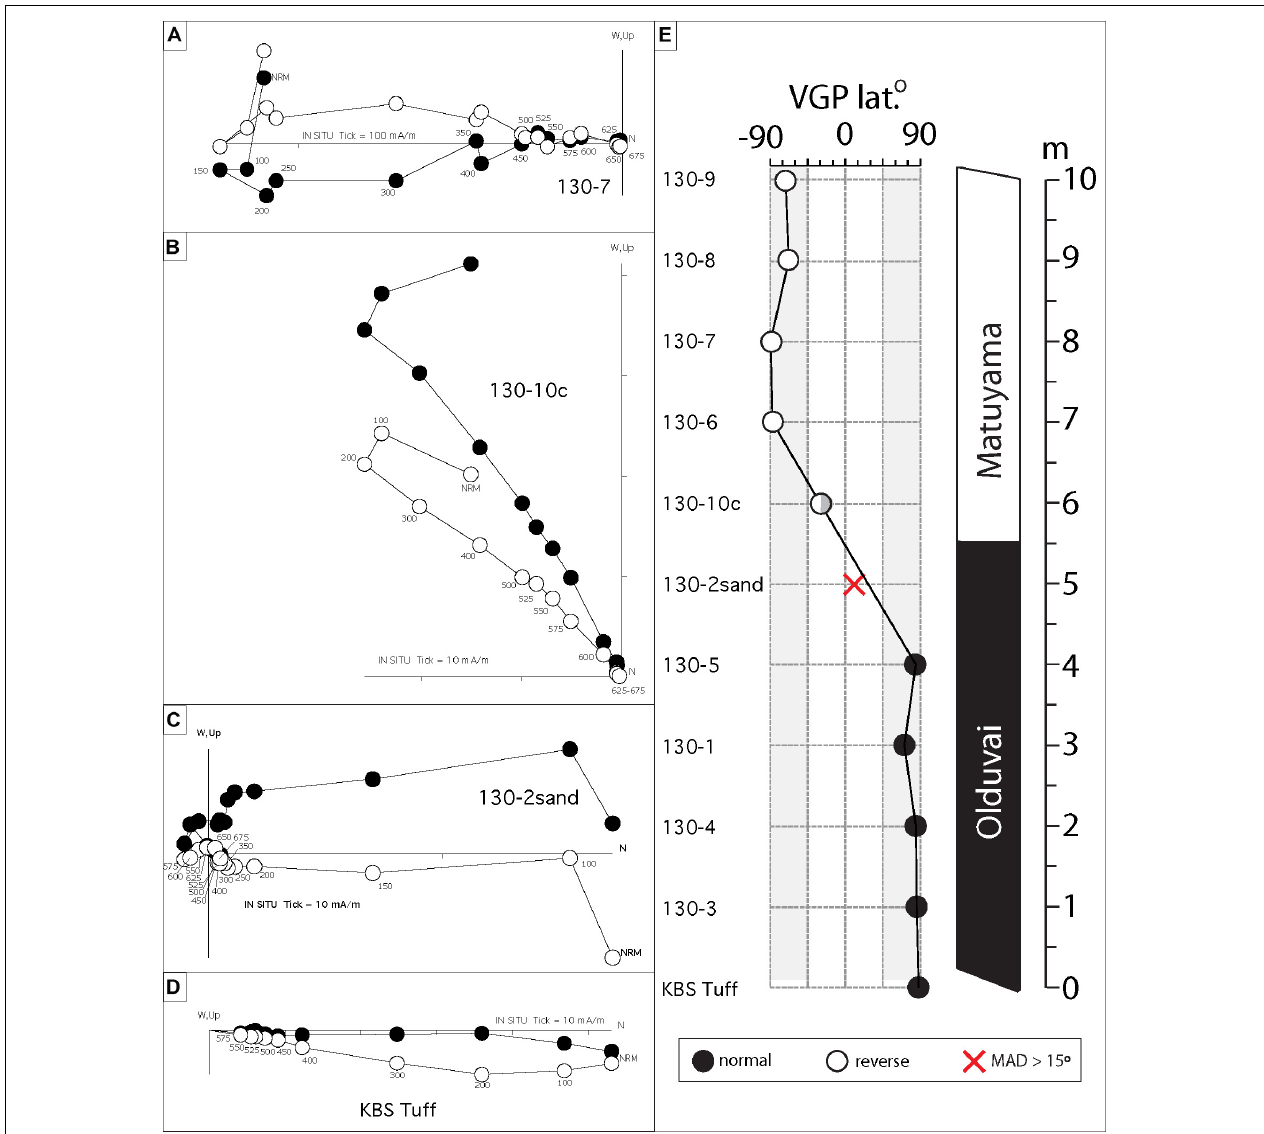
FIGURE 4 | Vector end-point plots of NRM thermal demagnetization data for representative specimens [ (A) 130-7, (B) 130-10c, (C) 130-2 sand, and (D) KBS Tuff] from the Area 130 section (see Figure 3 for stratigraphic positions). Open and closed symbols represent the vertical and horizontal projections, respectively, in bedding coordinates. Numbers next to symbols are thermal demagnetization steps in ◦ C. Coherent magnetizations are sometimes present above 575 ◦ C and suggest the presence of hematite in these samples. For sample 130-2sand the demagnetization trajectory clearly bypasses the origin and turns around to a reverse direction indicating a relatively strong normal polarity overprint. The Olduvai-Matuyama transition may be close to that sample level. (E) Results indicate the presence of a lower magnetozone of normal polarity from the KBS Tuff upwardly through the stratigraphic level of sample 130-5. An overlying magnetozone of reverse polarity is interpreted from samples 130-6 to 130-9 (filled black circles are normal polarity, open circles are reverse polarity, open circle with gray shading indicates probable reverse polarity with a declination direction within 90 ◦ of southerly, while the red cross symbol represents a sample with a MAD value > 15 ◦ and large normal polarity overprint, but has a thermal demagnetization trajectory that clearly bypasses the origin to reveal a reverse polarity